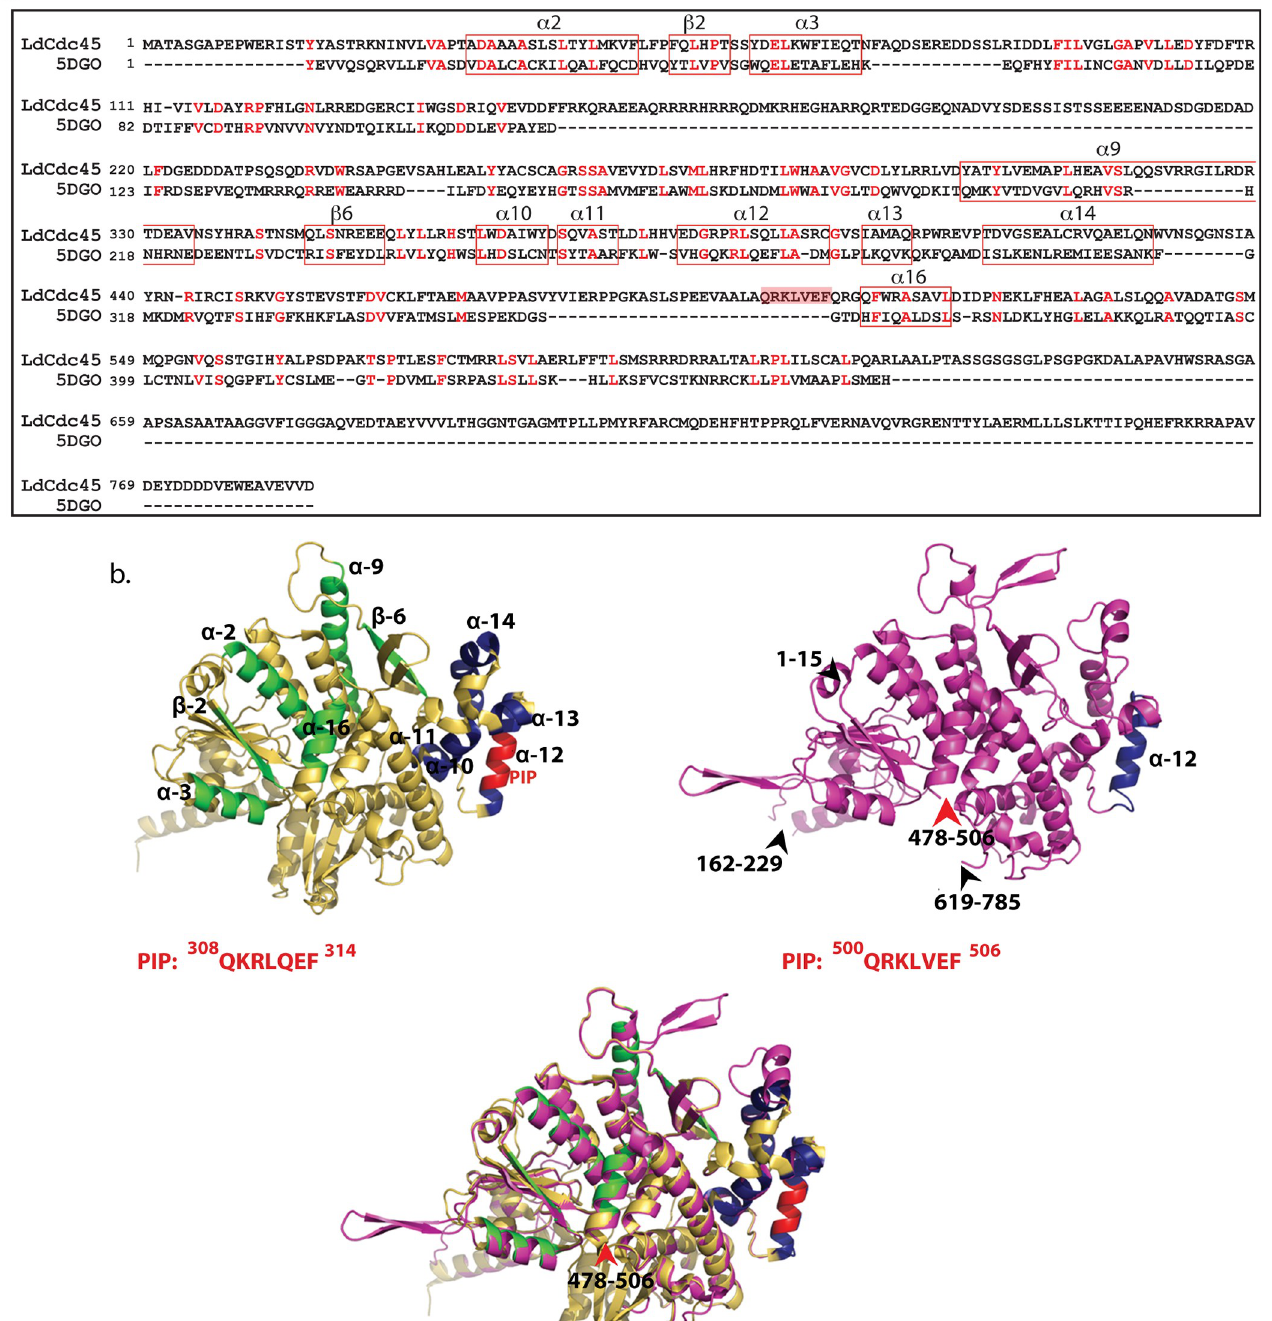
Fig 3. Structural analysis of Leishmania donovani Cdc45. a. Sequence alignment of Leishmania donovani Cdc45 against human Cdc45 generated by Phyre2. Based on structural analysis of human Cdc45 by Simon et al [9], α 10- α 14 are helices that form the Mcm2/5 binding face. All other marked helices and β strands represent regions involved in interaction with GINS b. Upper left panel: Human Cdc45 ribbon representation derived from crystal structure (PDB ID: 5DGO) as reported by Simon et al [9]. Navy blue regions: Complex Interaction Domain (CID) that interfaces with Mcm2/5. Green regions: Domains that interface with GINS complex. Red region: PIP box. Sequence of PIP box indicated below structure. Upper right panel: Ribbon representation (magenta) of 3D model of Leishmania donovani Cdc45 modelled using Phyre2 against human Cdc45 (PDB ID: 5DGO) as template. Navy blue region indicates α 12 helix. Black